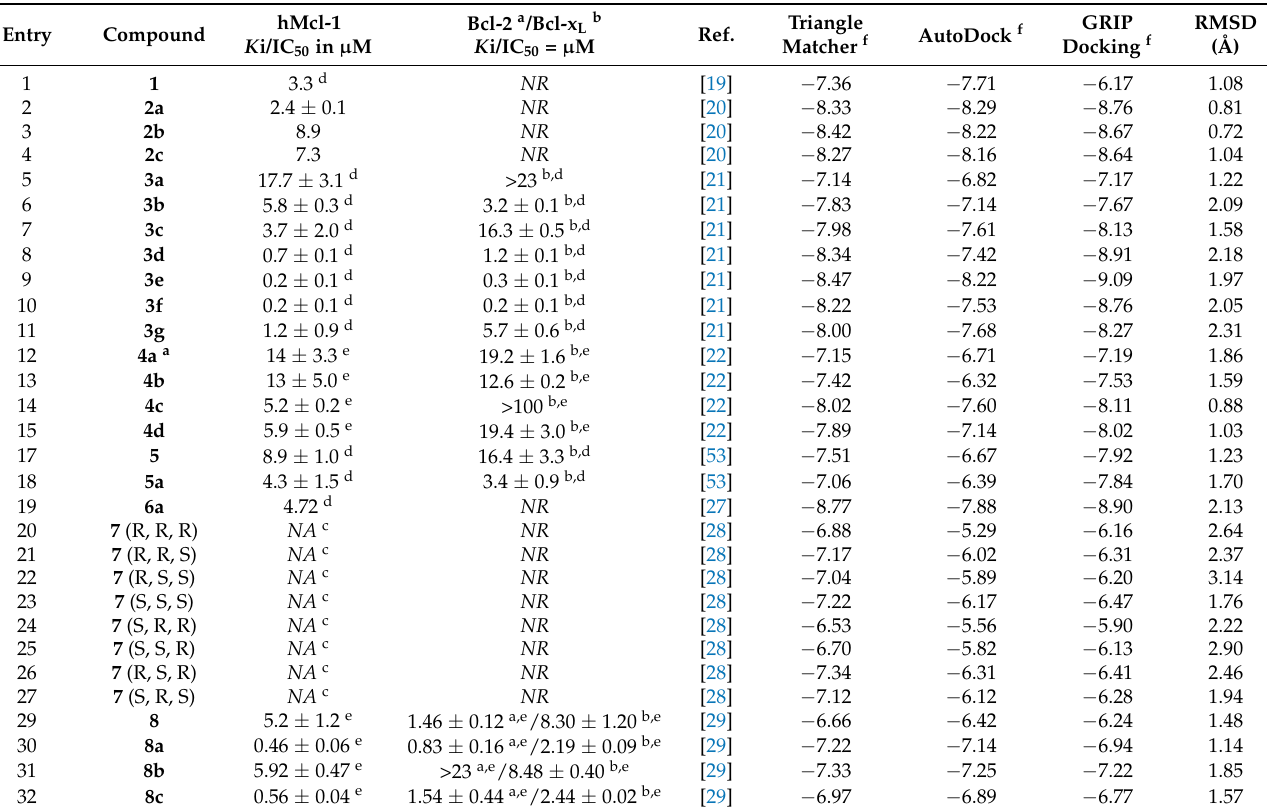
Table 7. Comparison of K i’s on hMcl-1 inhibition with their respective cumulative docking energies of naturally derived